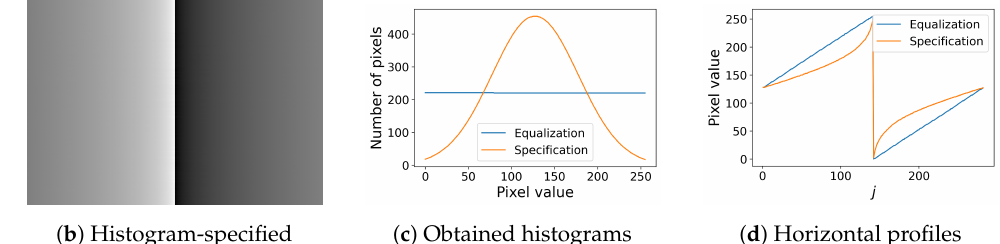
Figure 9. Exact histogram equalization and specification by the proposed method: ( a ) histogram- equalized image has the enhanced central edge; ( b ) histogram-specified image also has the enhanced edge; ( c ) histograms of the output images in ( a , b ) are equalized and specified to be Gaussian, respectively; ( d ) horizontal profiles in ( a , b ) have no fluctuation observed in Figure